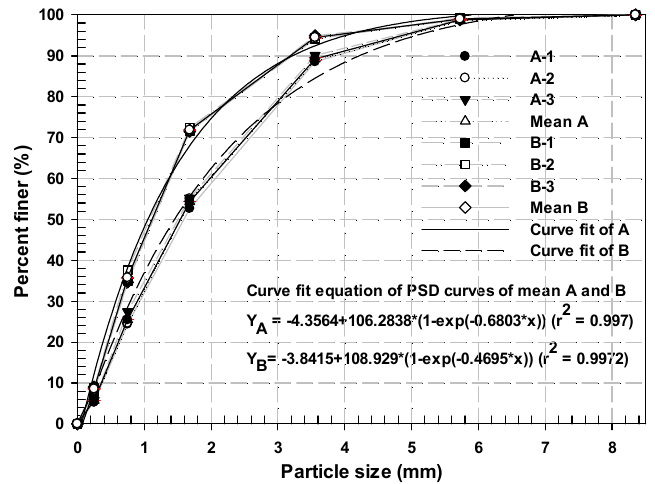
Figure 2. Particle size distribution curves and equations of the best curve fit of A and B. A: Turkey; B: China